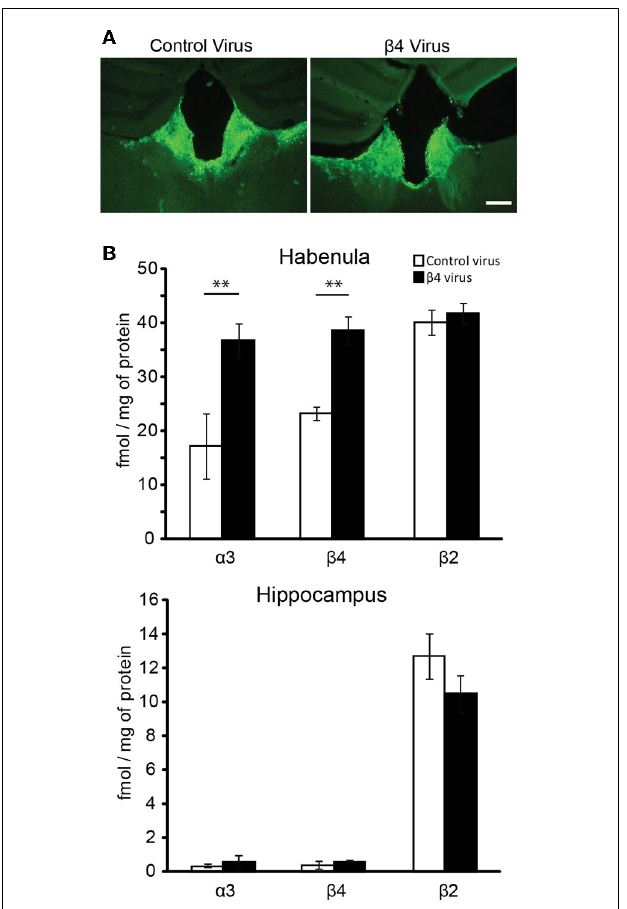
FIGURE 5 | Lentiviral mediated expression of β 4 in the Mhb and quantification by immunoprecipitation. (A) Representative coronal brain sections of mice injected with pFU-PE control virus or with the β 4 containing virus pFU- β 4-IRES-EGFP. (B) Quantitative immunoprecipitation, expressed as fmol/mg of protein of the solubilized [ 125 I]epibatidine-labeled receptors immunoprecipitated by the anti- α 3, - β 4, or - β 2 subunit specific antibodies (Grady et al., 2009). The solubilized [ 125 I]epibatidine-labeled receptors were obtained from the habenula and hippocampus of C57BL/6 mice injected with either control virus or virus carrying the β 4nAChR subunit ( n = 10 mice per group). ∗∗ p < 0 . 01, Student’s t